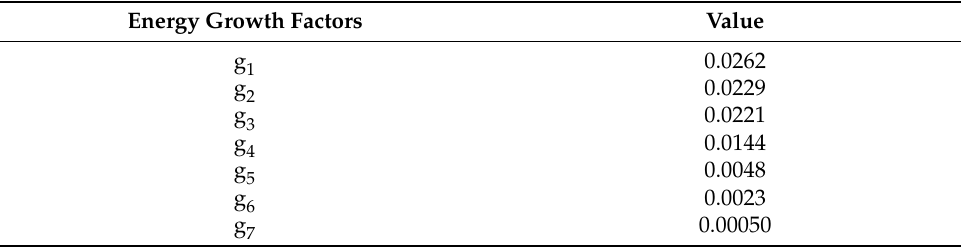
Table 4. Energy growth